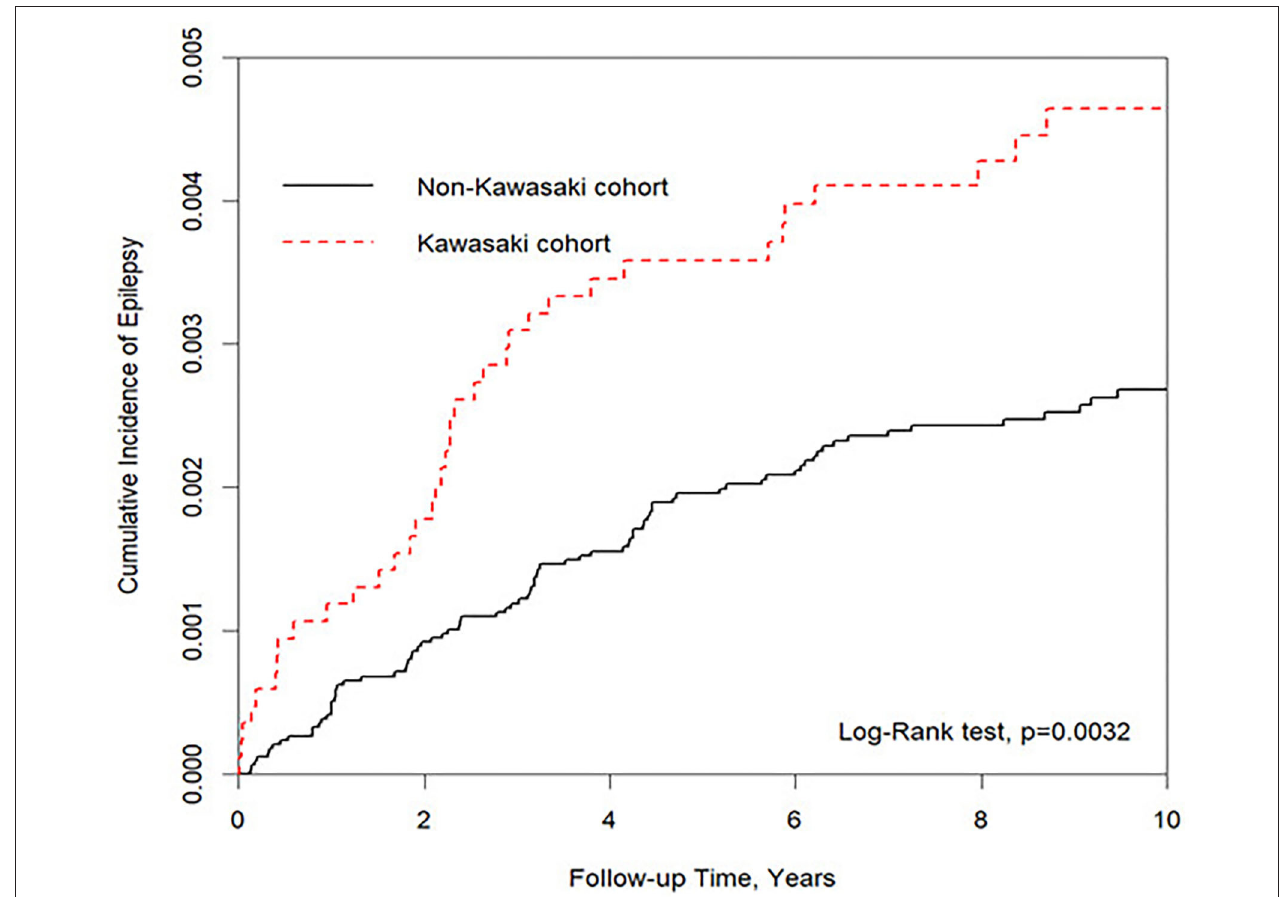
FIGURE 2 | Kaplan–Meier for cumulative incidence of epilepsy under aged stratified by Kawasaki disease with log-rank